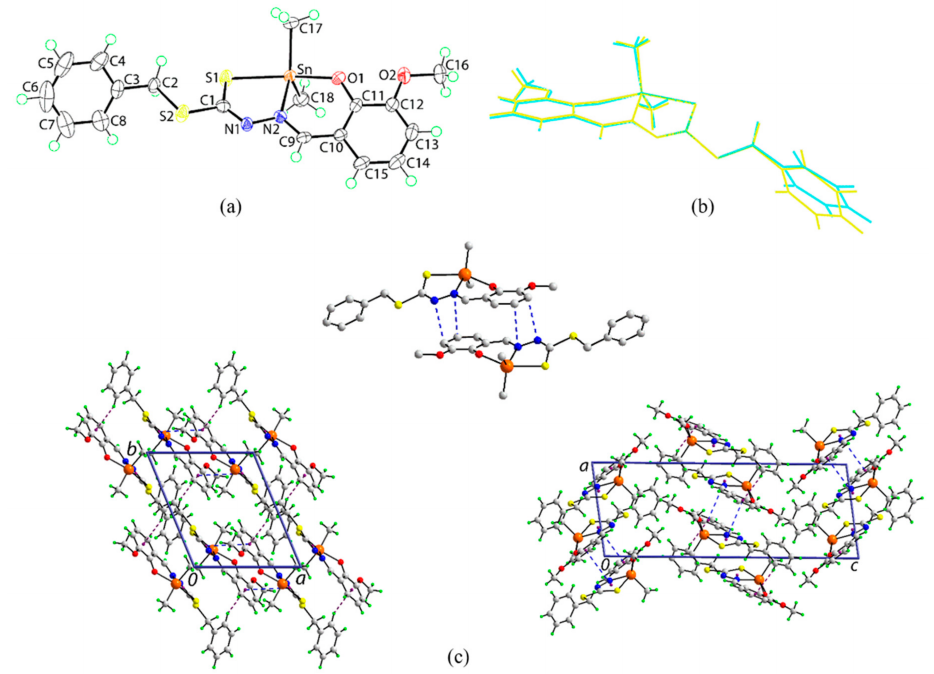
Figure 5. Crystallographic diagrams for Sn(SBoVa)Me 2 : ( a ) Molecular structure of the second independent molecule, molecule b, ( b ) overlay diagram of molecules a (yellow image) and b (aqua) drawn so the five-membered rings are overlapped and ( c ) supramolecular dimer sustained by edge-to-edge chelate ring ... benzene interactions (upper image) between Sn1-containing molecules, supramolecular layer sustained by edge-to-edge π (chelate ring) ... π (ethoxybenzene)